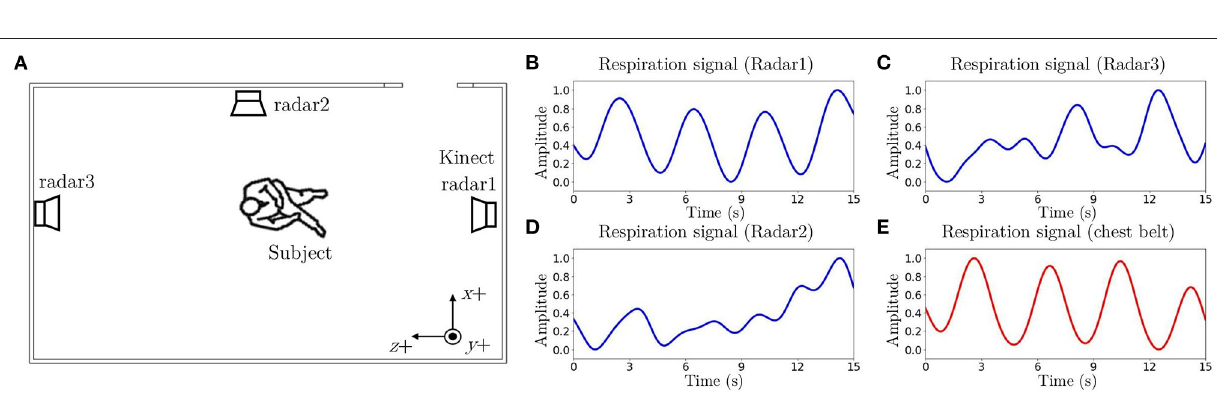
FIGURE 5 | An example of the relation between subject’s orientation and respiration signals. (A) A subject was sitting on a chair facing toward Radar1. (B) The respiration signal extracted from Radar1 ( RR est = 15.45 breaths/min). (C) The respiration signal extracted from Radar2. (D) The respiration signal extracted from Radar3. (E) The respiration signal detected by a reference breathing belt ( RR ref = 15.52